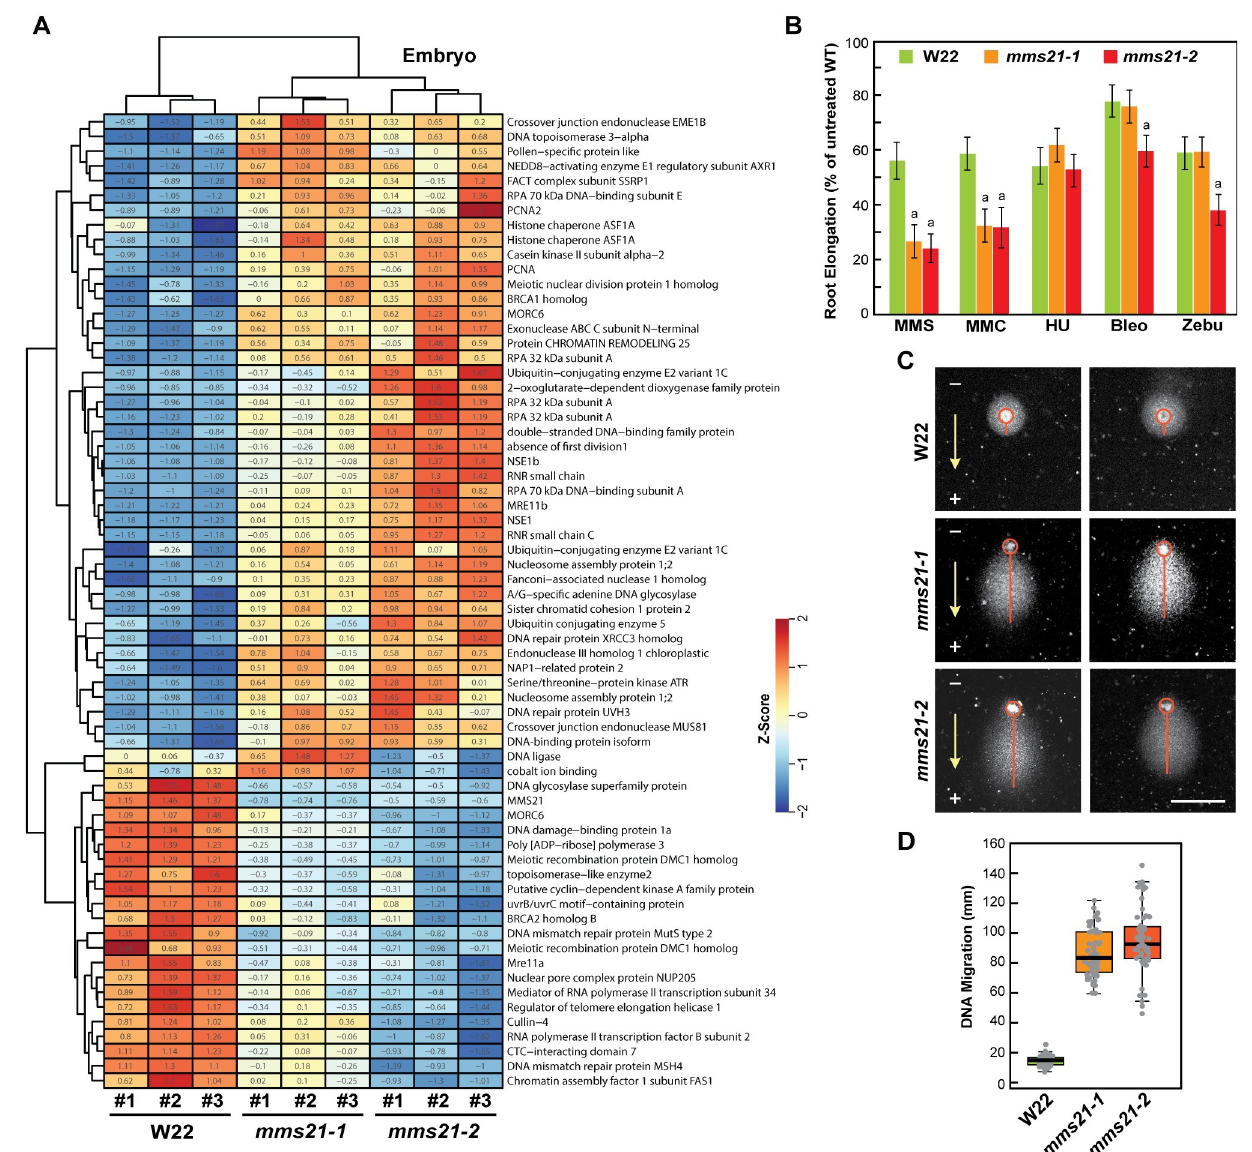
Fig 8. mms21 Mutants Have an Altered DNA Damage Response. (A) Genes associated with DNA repair have altered expression in the mms21 mutants. Shown are RNA-seq heat maps generated by Z scores from mms21-1 and mms21-2 embryos as compared to those from W22 focused on the altered expression of 66 genes associated with DNA damage repair. Each column represents an individual biological replicate; rows represent specific genes of interest. The numerical Z scores in each box shown standard deviations away from the mean. Groups of genes with similar expression patterns were clustered by columns and rows. (B) mms21 seedlings are hypersensitive to DNA-damaging agents. mms21-1 , mms21-2 , and W22 seeds were germinated on sterile filter papers and then transplanted to solid growth medium supplemented with 20 ppm methyl methanesulfonate (MMS), 2 μ M mitomycin-C (MMC), 1 mM hydroxyurea (HU), 100 nM bleocin (Bleo), or 10 μ M zebularine (Zebu). After one-week, root growth, was measured and plotted relative to that seen with untreated W22 roots. Each bar represents the mean of three biological replicates ( ± SD). (C) Comet assays measuring by electrophoretic mobility the extent of DNA breaks. DNA from nuclei isolated from mms21-1 , mms21-2 , and W22 roots were subjected to agarose gel electrophoresis and then stained with propidium iodide. Mobility of the DNA was measured by the distance from the center of the nucleus to the edge of the comet tail. Scale bar = 50 μ m. (D) Quantification of the comet assays in panel (C) by box plots based on the distribution of comet tail lengths for individual nuclei. The bottom and top of each box indicate the first (Q1) and third (Q3) quartiles, and the middle line reflects the median; the upper-limit equals Q3 plus 1.5 times interquartile range (IQR), and the lower-limit equals Q1 minus 1.5 times IQR. Each dot represents a single measurement (n = 50